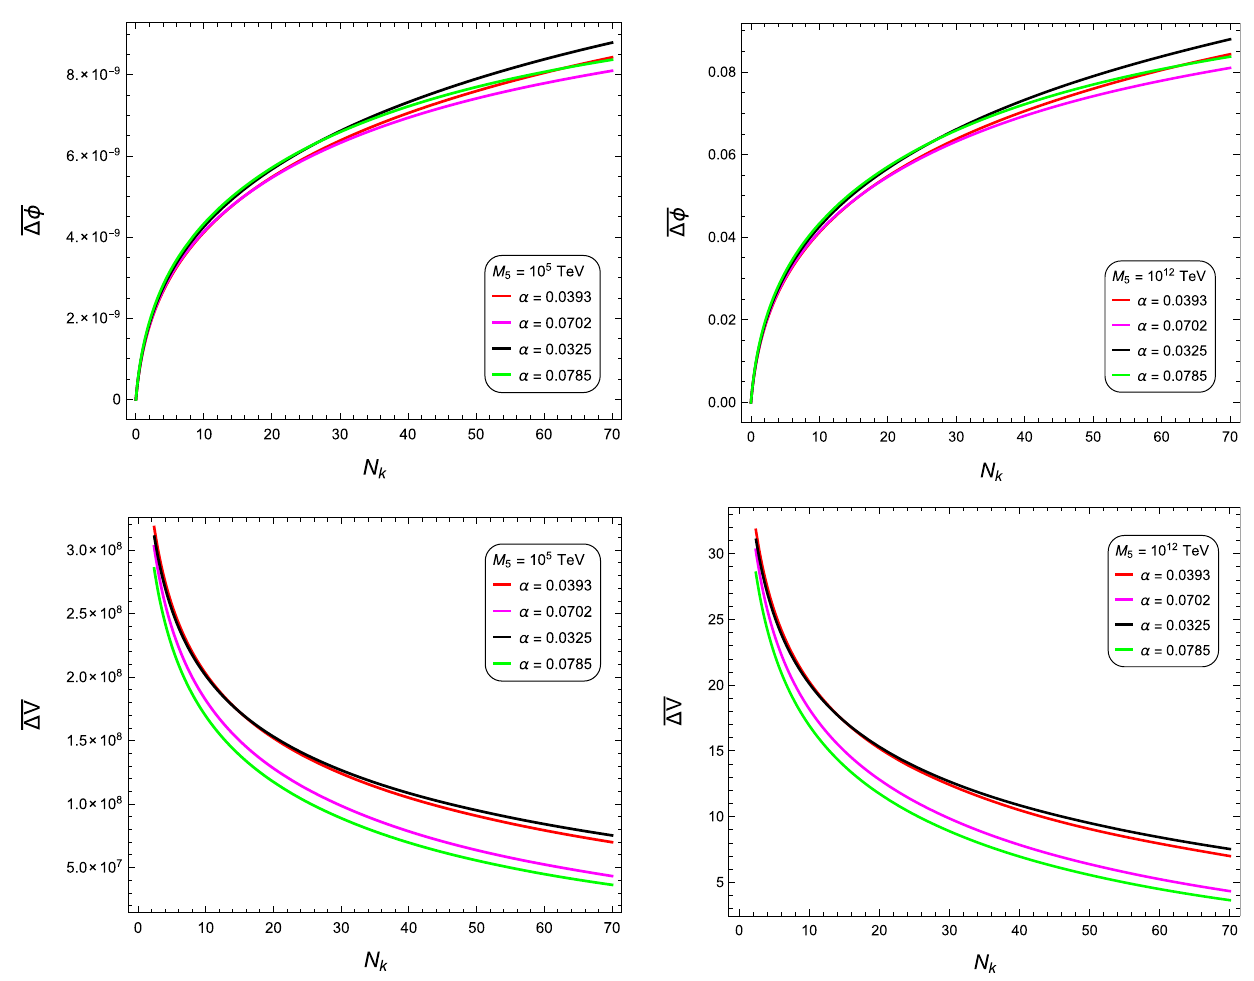
Fig. 2 Plots of the Swampland criteria for M 5 = 10 5 TeV (left) and M 5 = 10 12 TeV(right)intermsofthenumberof e -foldsforthedifferent values of α . Top panels show the behaviour of the distance conjecture